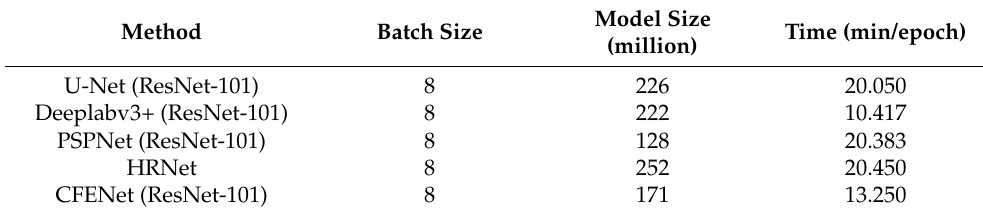
Figure 10. Comparison of experimental results and model sizes of different methods. Line graphs with different colors represent the results of different evaluation metrics. The histogram represents the model sizes of different methods. Table 4. Comparison of the efficiency of different methods. Different methods are trained on the WHU Building Dataset for 200 epochs, and the batch size is set to 8. The column “Model Size” represents the total model size of each method. The column “Time” represents the time required to train an